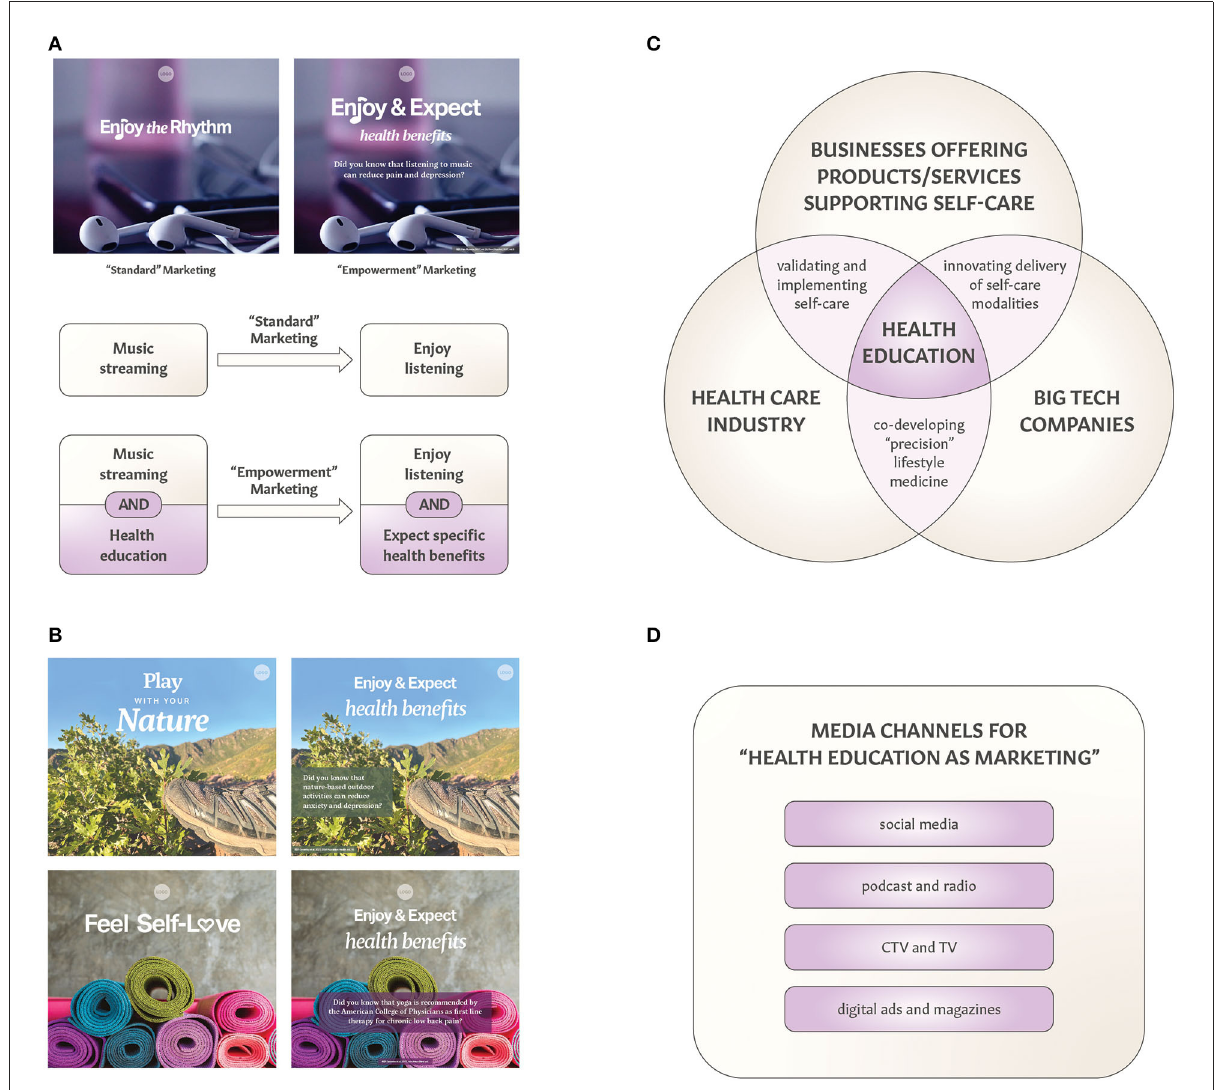
FIGURE1 “Health education as marketing” for consumer products and services. (A) Comparing “standard” marketing with health-focused “empowerment” marketing of music streaming (or audio equipment) illustrates opportunities to build associations between listening to music and receiving such health benefits as reduction of pain or depression. The statement shown in this digital ad “Did you know that listening to music can reduce pain and depression” is supported by systematic review and meta-analysis studies referenced in Table 1. (B) Examples of “standard” and “empowerment” marketing of products and services associated with contact with nature and yoga practice. The statements shown in these digital ads “Did you know that nature-based outdoor activities can reduce anxiety and depression?” and “Did you know that yoga